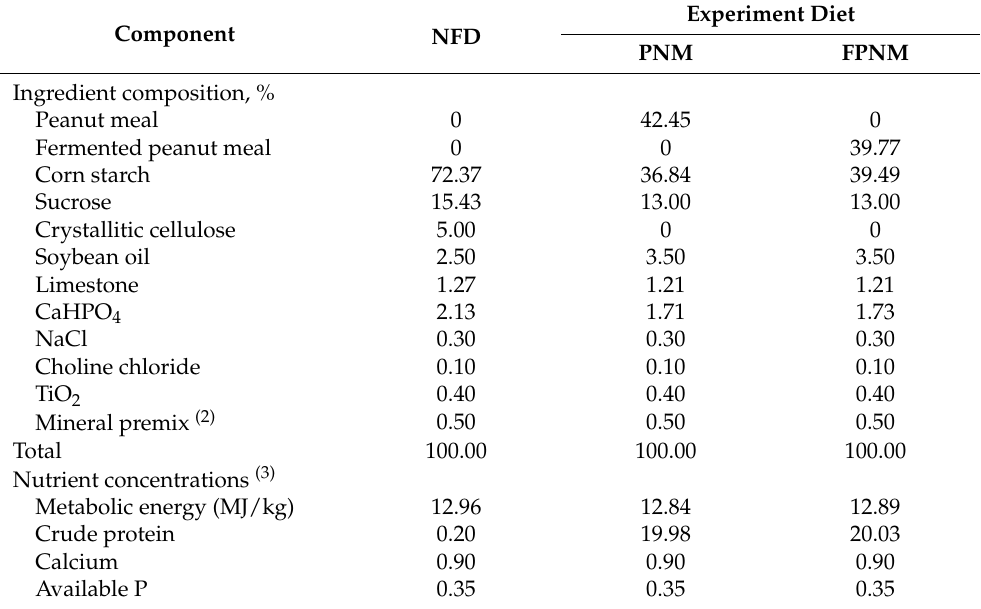
Table 1. Ingredient composition and nutrient concentration of the experimental diets used in the determination of the standardized ilea amino acid digestibility (dry matter basis) (1)